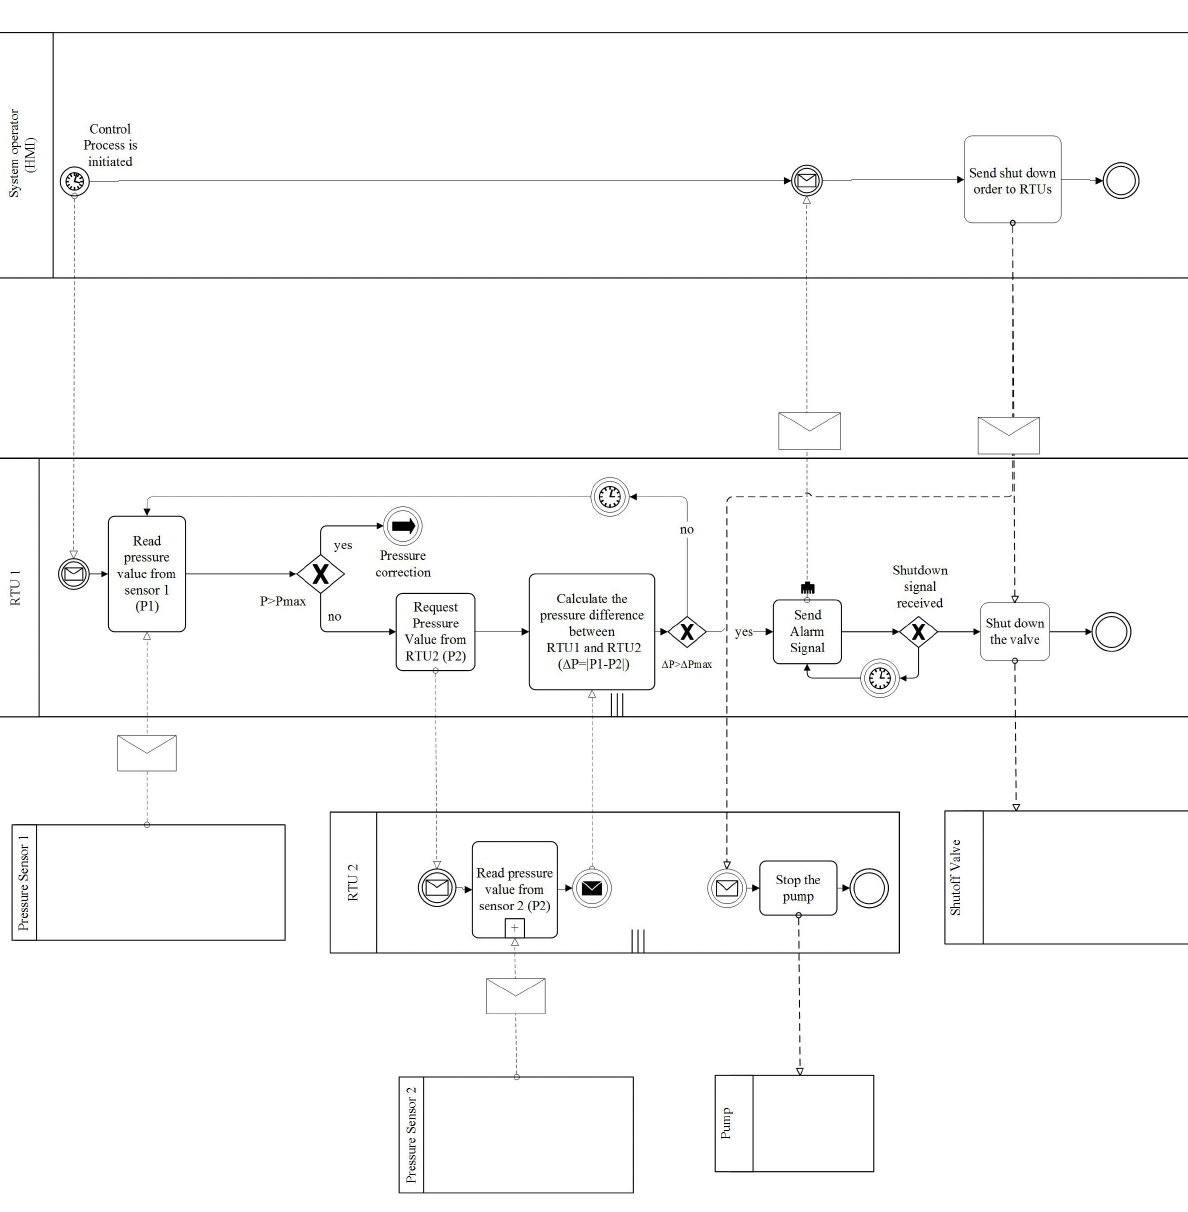
Figure 4. Exchange of Information between Devices in a SCADA System in the Water Distribu- tion